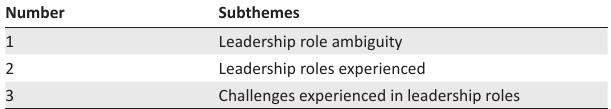
TABLE 1: Nurse managers’ experiences of their leadership roles in a specific mining primary healthcare service in the West